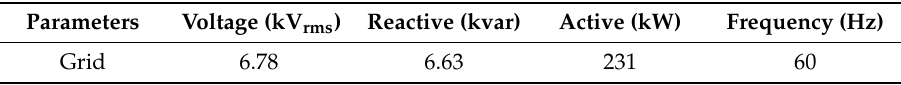
Figure 9. ( a ) Power (active and reactive); ( b ) voltage (Peak and RMS); ( c ) frequency waveform in steady state. Table 1. Marado Island Grid Parameters .